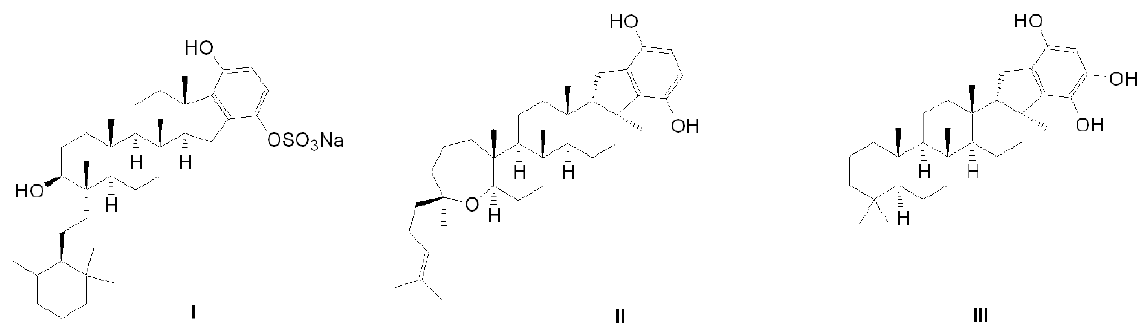
Fig. 1 Naturally occuring Terpenoid Structures featuring an annelated areno moiety: adociasulfate 1 (I) from the Paluan sponge Haliclona (aka Adocia) [1–3], haliclotriol B (II) from the Indo-Pacific sponge Haliclona [4], and disidein (III) from the sponge Disidea pallescens